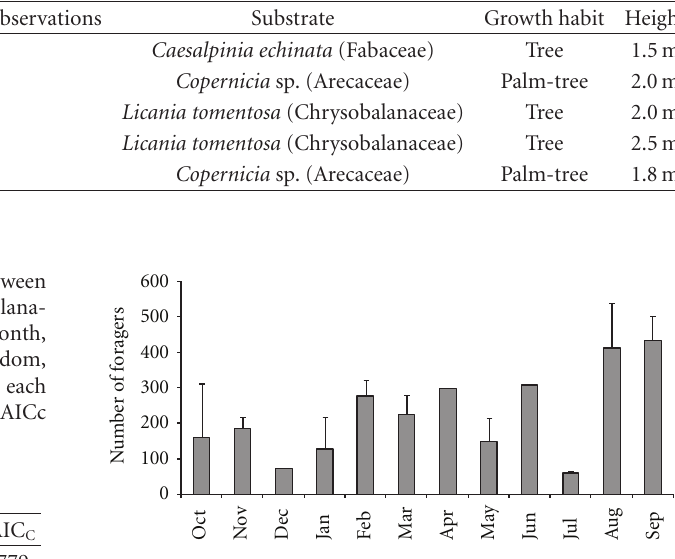
Figure 1: Mean number of foragers of Polybia paulista observed returning to the nest per day for each month of observation. Each day was sampled four times, during 15 minutes each. Thin bars are standard